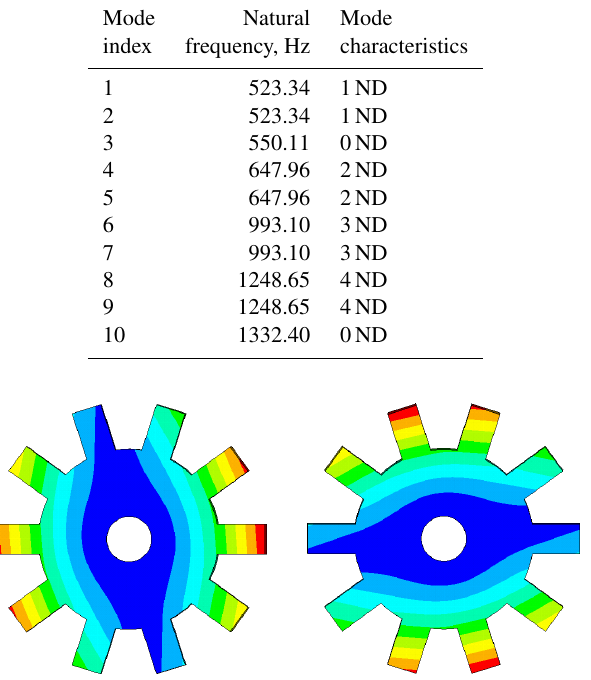
Figure 2. The 1ND mode shapes of a disk without a crack.